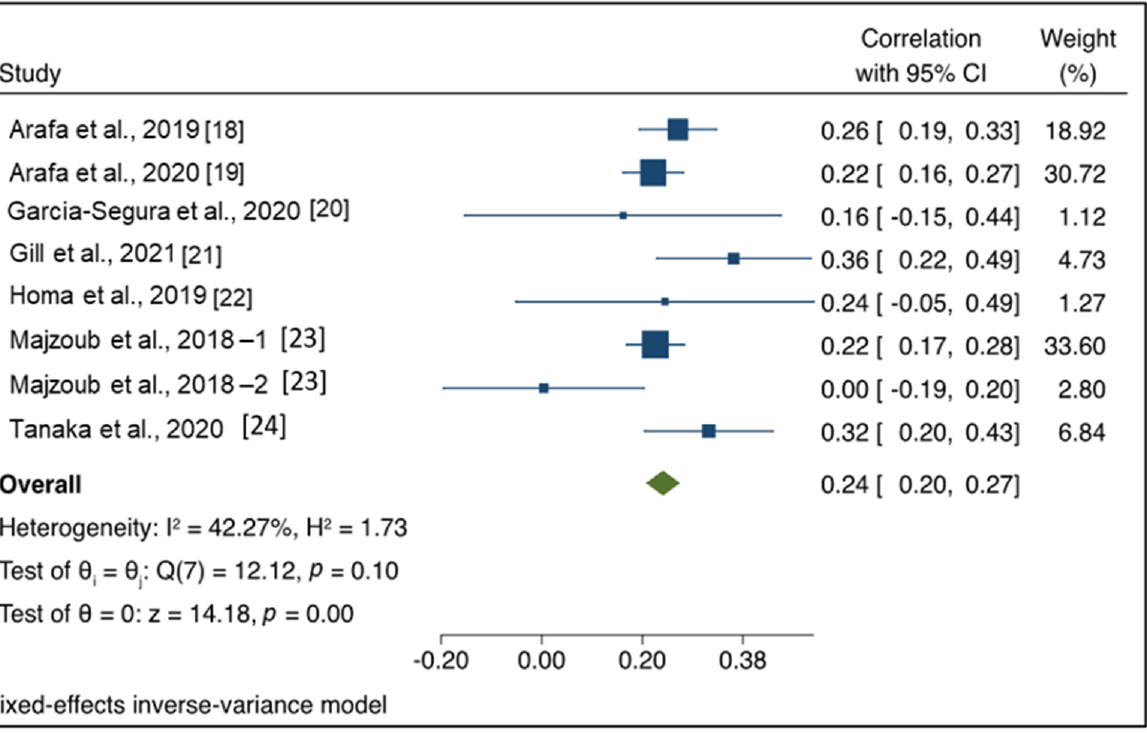
Figure 2. Forest plot of correlation coefficient between seminal oxidation-reduction potential and sperm DNA fragmentation.